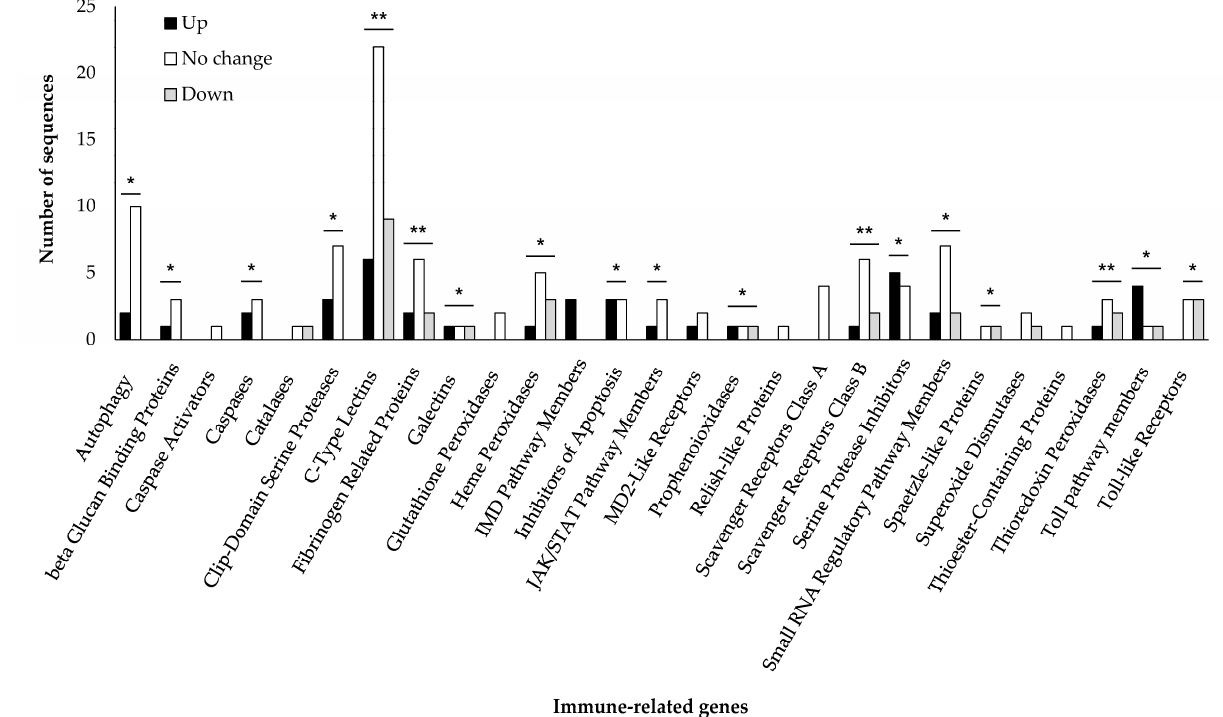
Figure 5. Expression of immune-related genes in JPS beetles in response to M. anisopliae JEF-197 fungal treatment. Immune- related genes in JPS beetles whose expression was altered by JEF-197 fungal treatment were determined by Blast2GO based on an arthropod immune-related gene database in immunoDB (E-value < 1.0 × 10 − 100 ). Genes that showed over 2-fold upregulation or 0.5-fold downregulation were considered upregulated and downregulated, respectively. Differences between groups of gene expression levels in adults with JPS within the immune class were analyzed using a one-way ANOVA in SPSS using a significance level of 0.05 ( α ). * represents a significant difference in the level of gene expression in the two groups, and ** represents a significant difference in the level of gene expression in the three groups.